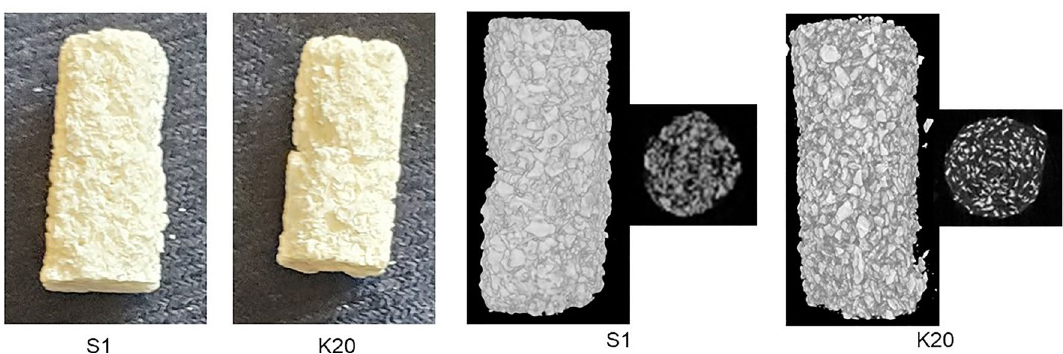
Figure 1. Schematic illustration of the polyurethane-based bone filler scaffold. Left : Photograph of the S1 and K20 scaffolds formulated in a size (approximately 1 cm in length) and shape to match the bone defect generated in our rabbit model. Right : reconstructed scaffold µCT images and raw µCT cross sections of S1 and K20 scaffolds prior to antibiotic